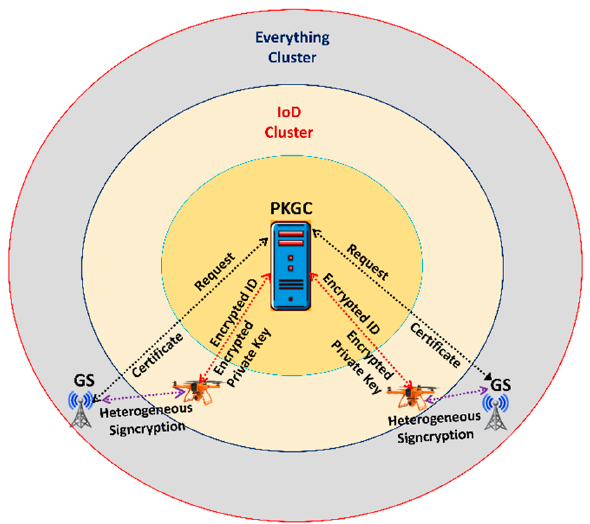
Figure 1. Network model of the proposed